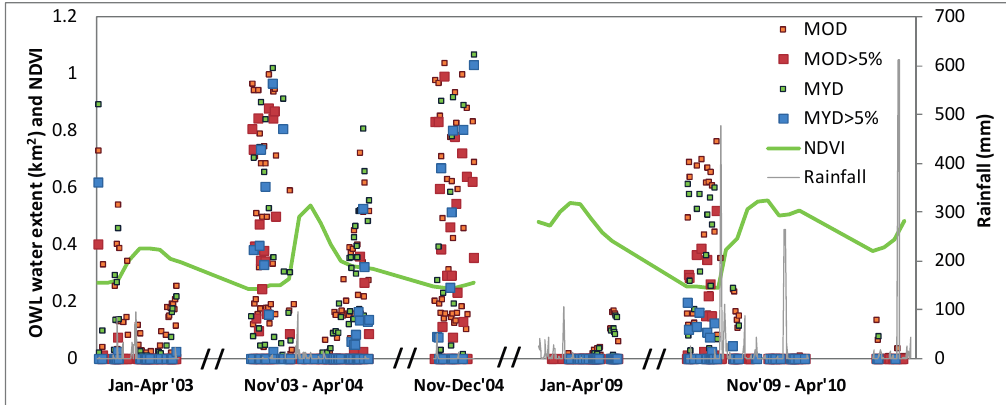
Figure 4. Total MODIS OWL flood extent for the MOD and MYD data for Site D2, for the 2003, 2004, 2009 and 2010 wet seasons. MODIS OWL flood extent using only those pixels mapping greater than 5% inundation is also shown, along with rainfall. The NDVI is also